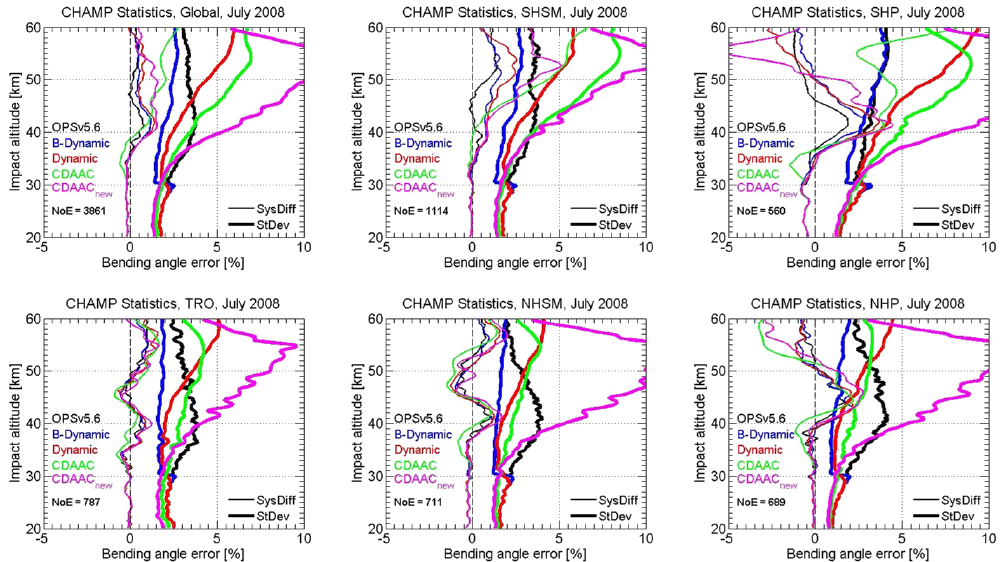
Figure 11. Systematic differences (SysDiff, light lines) and standard deviations (SD, heavy lines) of statistically optimized bending angles, relative to co-located ECMWF analysis bending angles used as a reference, of CHAMP events from July 2008. Statistics for the OPSv5.6 (black), b-dynamic (blue), dynamic (red), CDAAC (version 2009.2650, green), and CDAAC new (version 2014.014, magenta) statistical optimization algorithms are shown for the same six regions as in Fig. 10. The figure layout is the same as for Fig. 10.